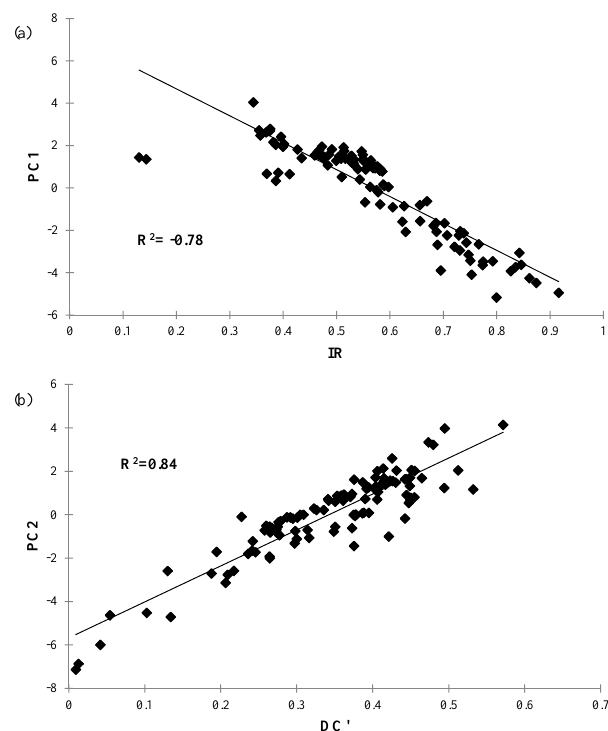
Figure 7. Scatterplots of (a) PC1 against the IR ( R 2 = 0.78) and (b) PC2 against DC’ ( R 2 = 0.84) for the entire set of samples used in this